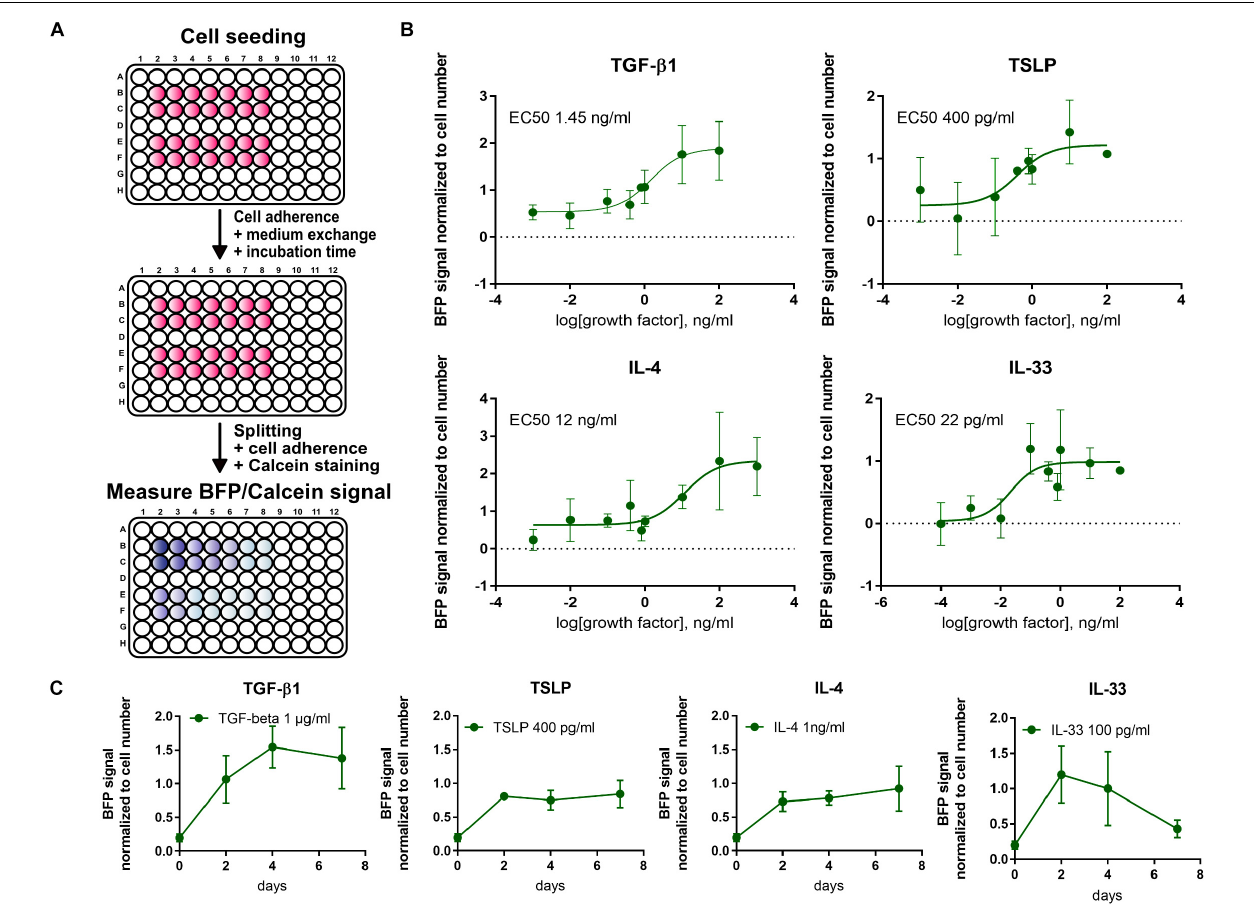
FIGURE 7 | High-throughput screening using the 10-4A BFP cell line. (A) Schematic of plate reader assay to study the fibrotic response of 10-4A BFP to cytokine treatment in live cell assays. For normalization to the cell number, cells were stained with Calcein AM. (B) Dose-response curves of BFP expression in 10-4A BFP cells in response to 2 days exposure with increasing doses of TGF- β 1, TSLP, IL-4, and IL-33. (C) Time-response curve of 10-4A BFP cells to continuous exposure to TGF- β 1, TSLP, IL-4, and